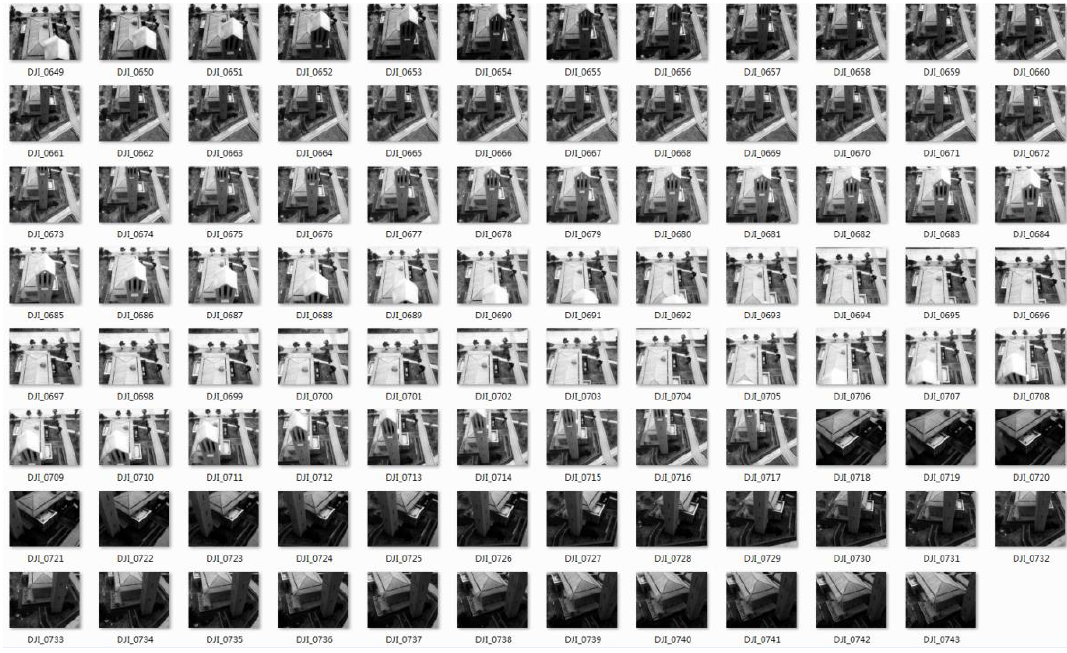
Figure 5. The images acquired.